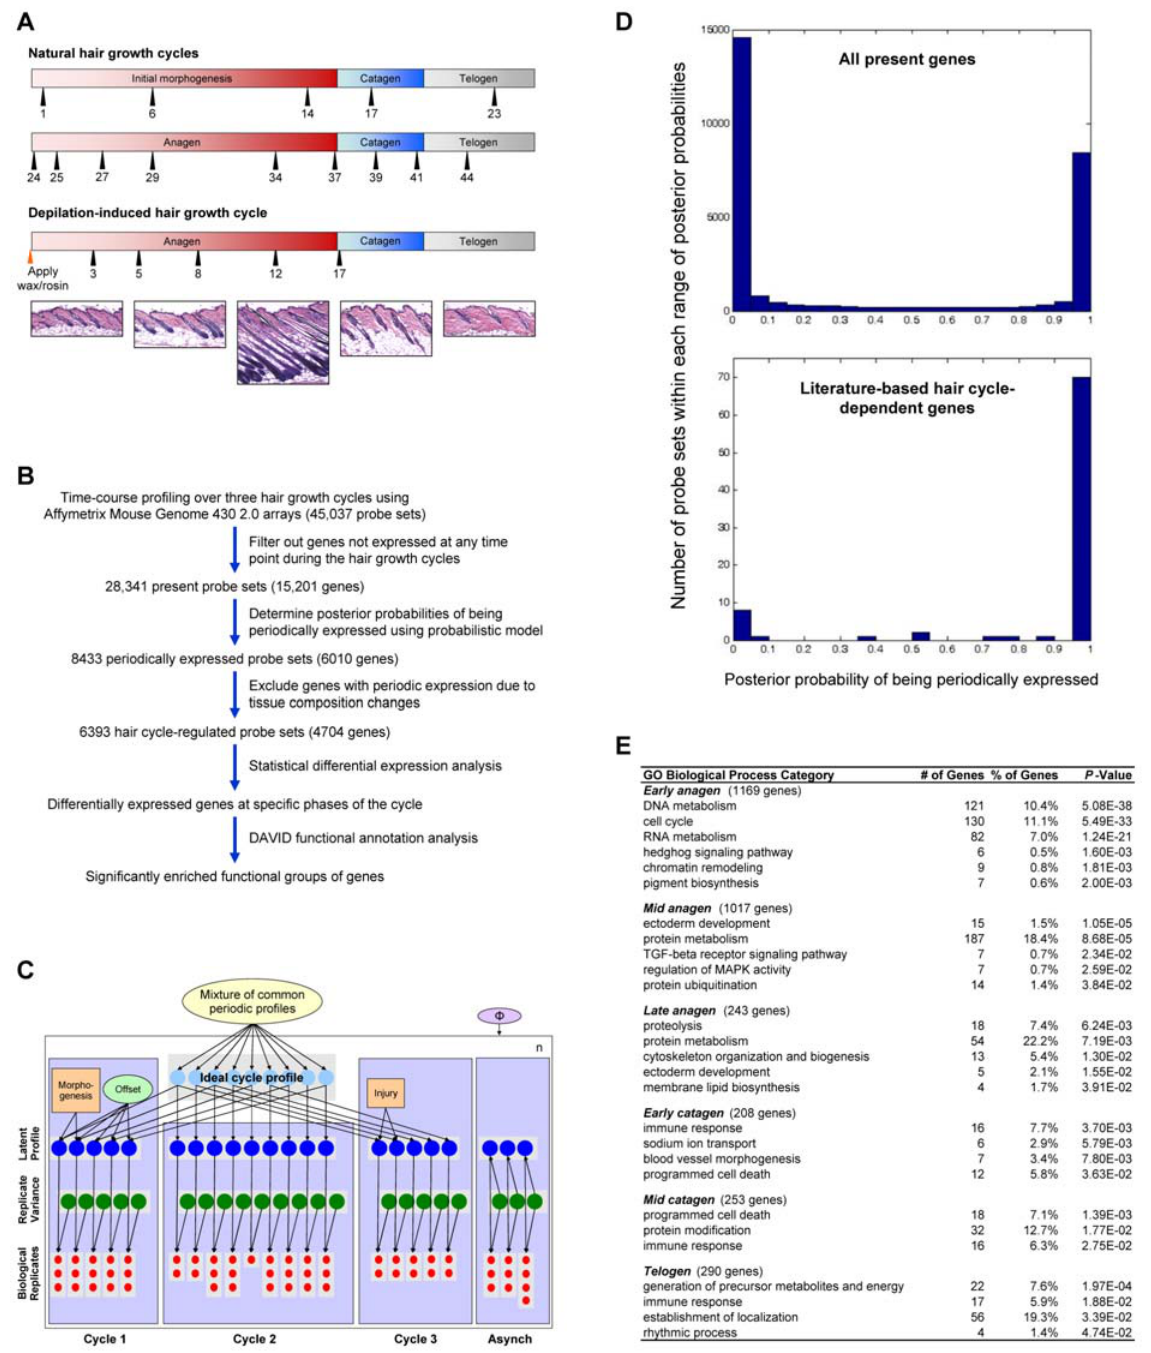
Figure 1. Identification of hair cycle–regulated genes using probabilistic models. (A) Representative time points selected for gene expression profiling of the natural and depilation-induced hair growth cycles. Time points for natural cycles represent postnatal days, and time points for depilation-induced cycle indicate the number of days following depilation. Since the three cycles have different duration, the schematic timeline is not in actual time scale. Bottom panel consists of representative histology of dorsal skin at key phases of synchronized hair follicle cycling. (B) Overview of data processing and statistical analyses. Note that samples for the first synchronized hair growth cycle and asynchronous time points were profiled in an earlier study using an older generation array (Affymetrix Murine Genome U74Av2). (C) Schematic of the probabilistic model for detection of periodic gene expression changes during hair follicle cycling. See Materials and Methods for a detailed description of the schematic. Asynch – asynchronous cycle. (D) Histogram of the number of probe sets within each range of the indicated posterior probabilities of being periodically expressed. Top panel is the histogram of probabilities for all present genes during the hair growth cycle. The bottom panel is the histogram of probabilities for the literature-based hair cycle-dependent genes. (E) List of significantly enriched GO Biological Process categories within the sets of genes specifically upregulated at the indicated phases of the hair growth cycle. Due to the redundancy of categories, not all are listed. The number of genes upregulated at each phase of the cycle is in parentheses. Statistical enrichment of each category is shown as P -values calculated using a modified Fisher Exact test (DAVID functional annotation analysis). doi:10.1371/journal.pgen.1000573.g001 PLoS Genetics | www.plosgenetics.org